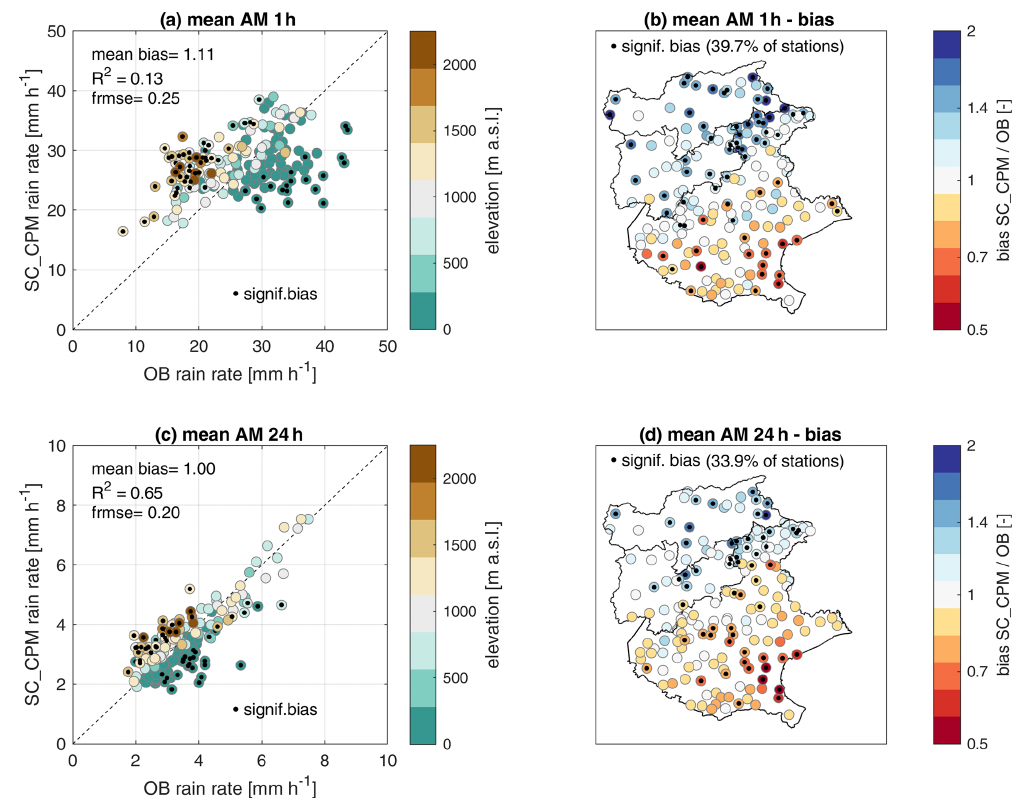
Figure 3. Comparison of observed and simulated annual maxima at 1 and 24h durations. (a, c) Rainfall rate for average annual maxima for station-colocated CPM (SC_CPM) versus observed values (OB) at 1h (a) and 24h durations (c) ; the color of the dots indicates the elevation of the station; and mean bias, coefficient of determination ( R 2 ), and fractional mean squared error (fmse) are also shown. (b, d) Maps of SC_CPM/OB relative bias for the 1h (b) and 24h (d) mean AM. In all panels, significant differences at the 5% level are indicated by a black dot, and their proportion is reported as the percentage of significant cases to the total number of